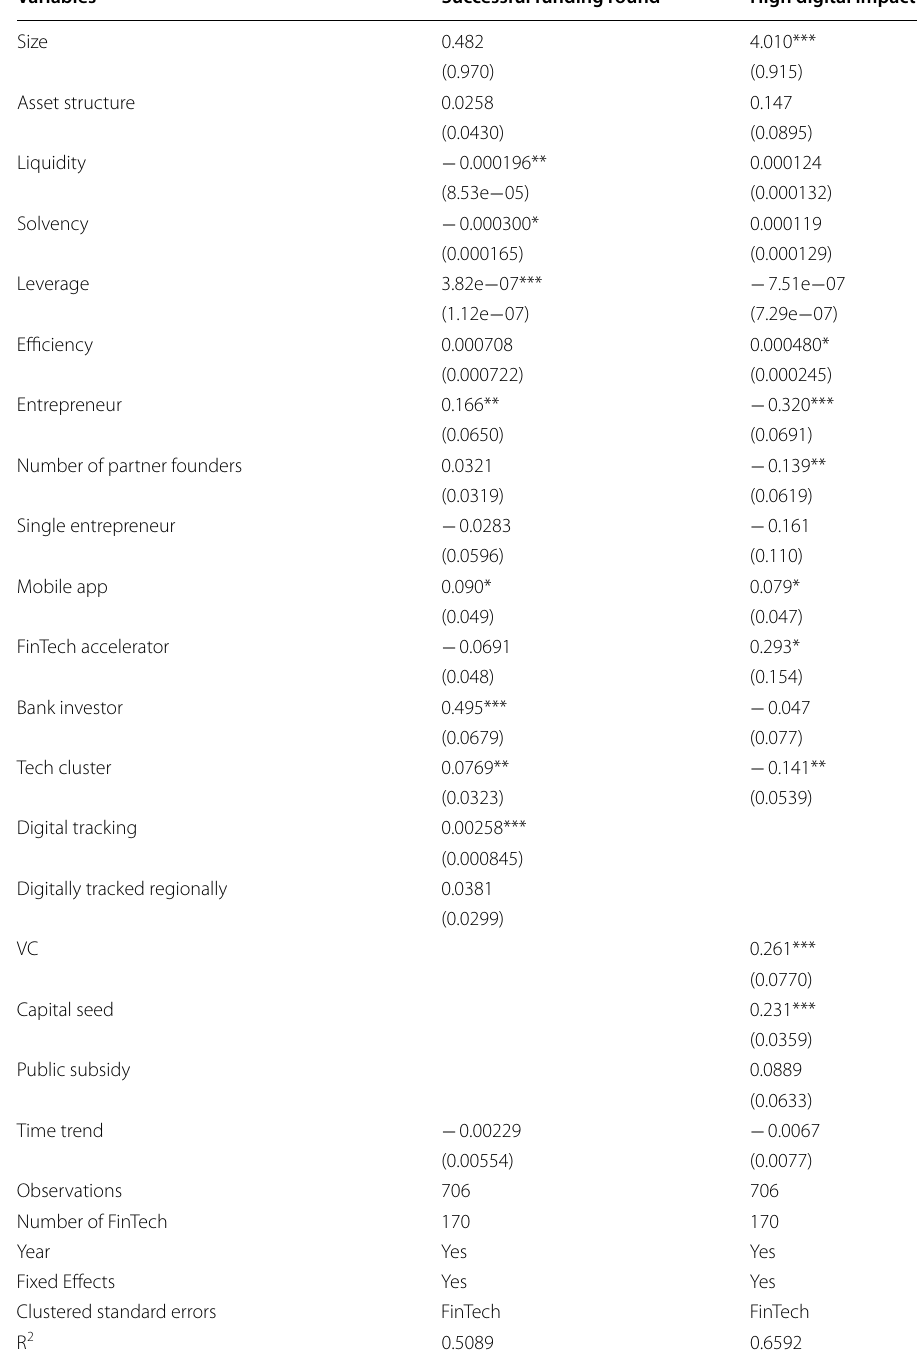
Table 12 Alternative performance measures: successful funding round and digital